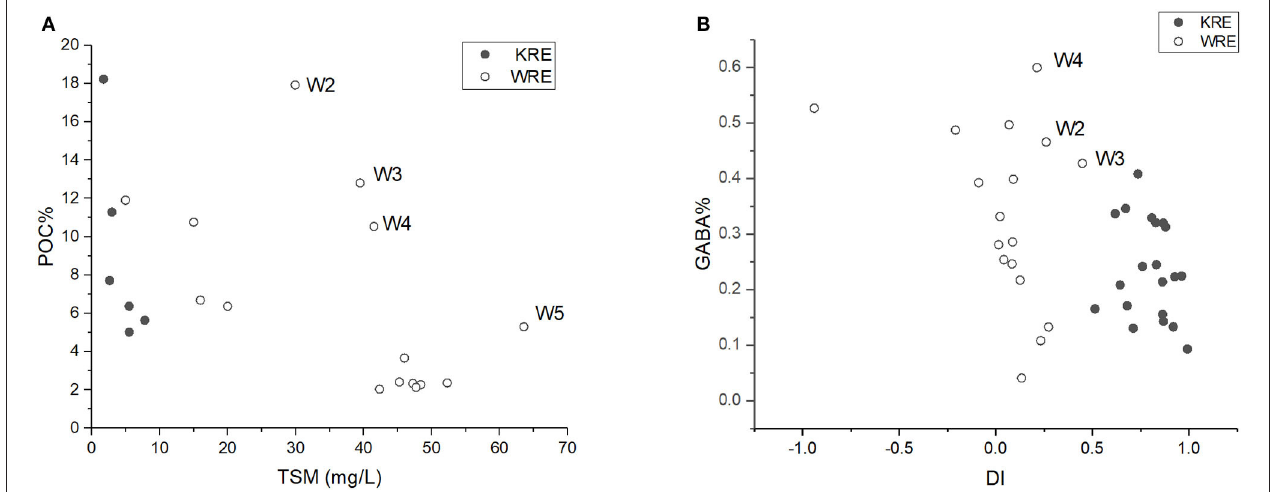
FIGURE 10 | (A) POC (in %) plotted against total suspended matter (TSM) in the WRE and the KRE (surface samples only). (B) GABA% plotted against DI for the WRE and the KRE (all layers).